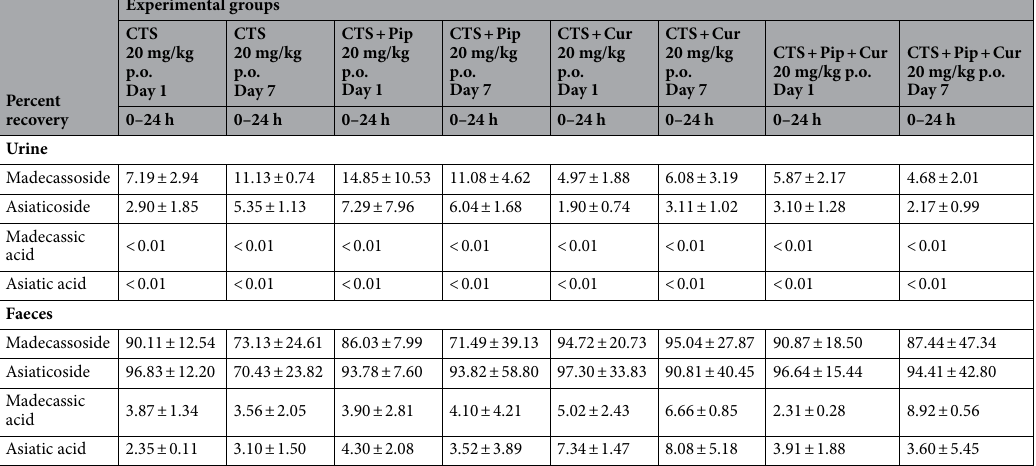
Table 4. Percentage recovery of madecassoside, asiaticoside, madecassic acid, asiatic acid in excreta of all experimental groups. CTS Centell-S, Pip piperine, Cur curcumin. Data are expressed as mean ± SD (n = 4).